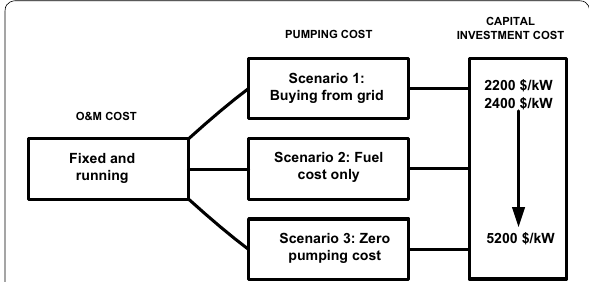
Fig. 5 Pumping cost scenarios in combination with different invest‑ ment/capital